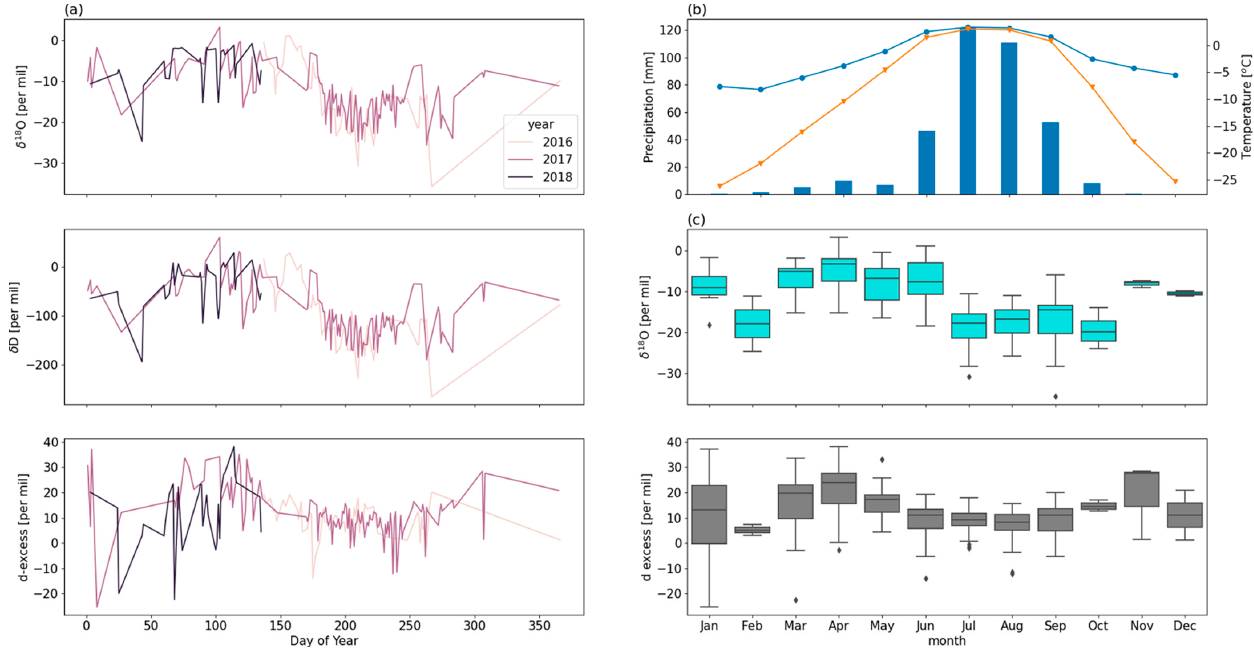
Figure 2. Variation in δ 18 O in daily meteoric water at Lobuche and climatic seasonality based on hourly data during 2004–2008. ( a ) daily time series of meteoric water δ 18 O at Lobuche during 2016–2018, ( b ) five-year climatology of precipitation amount (bars), air temperature (blue curve), and dew-point temperature (orange curve) at the station, and ( c ) monthly boxplot of daily meteoric isotopes during the observation period.